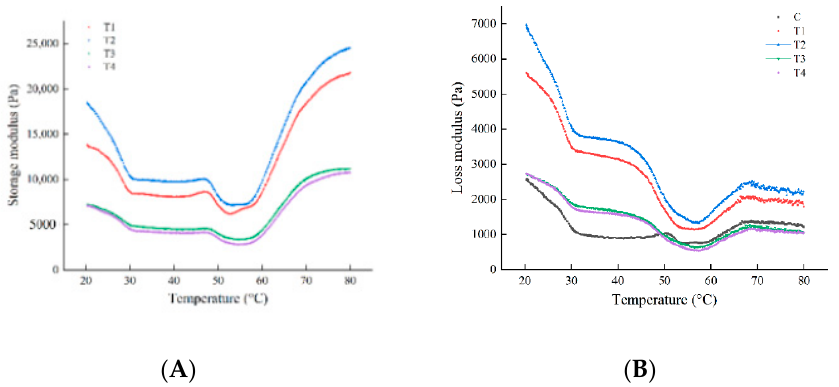
Figure 3. Changes in storage modulus (G (cid:48) ) ( A ) and loss modulus (G (cid:48)(cid:48) ) ( B ) during heating from 20 ◦ C to 80 ◦ C for meat batter prepared with various amounts of Oudemansiella raphanipies powder (ORP); C: meat batter without ORP; T1: meat batter containing 1% ORP; T2: meat batter containing 2%